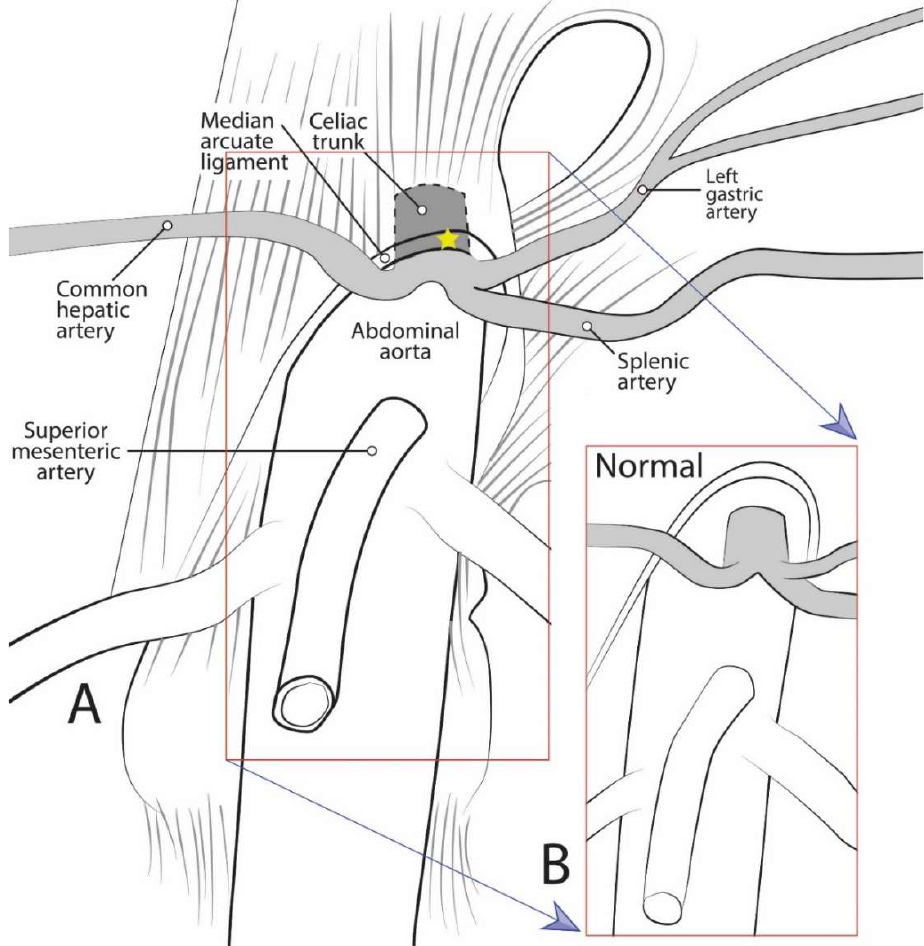
Figure 1. Diagrammatic representation of celiac trunk anatomy, showing: ( A ) The median arcuate ligament compressing the celiac trunk as in median arcuate ligament syndrome; and ( B ) normal anatomical condition.